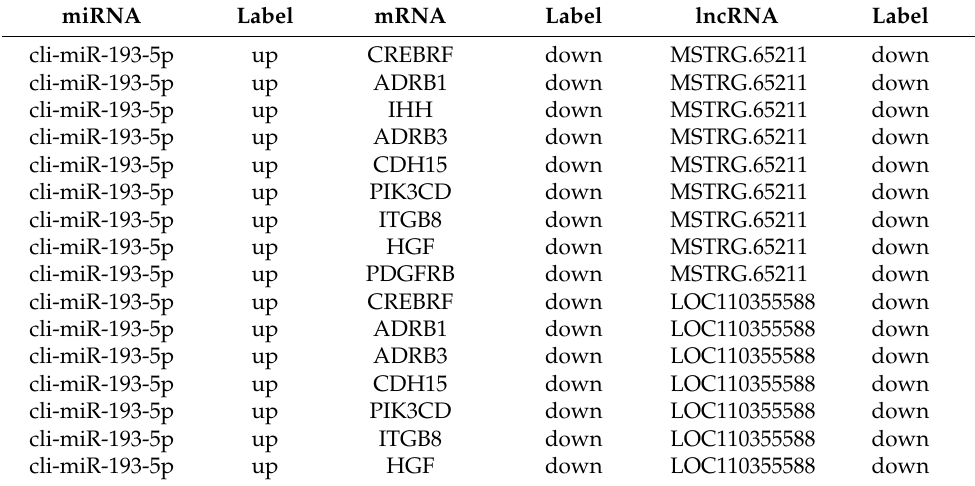
Table 4. Key ceRNA regulation axis.